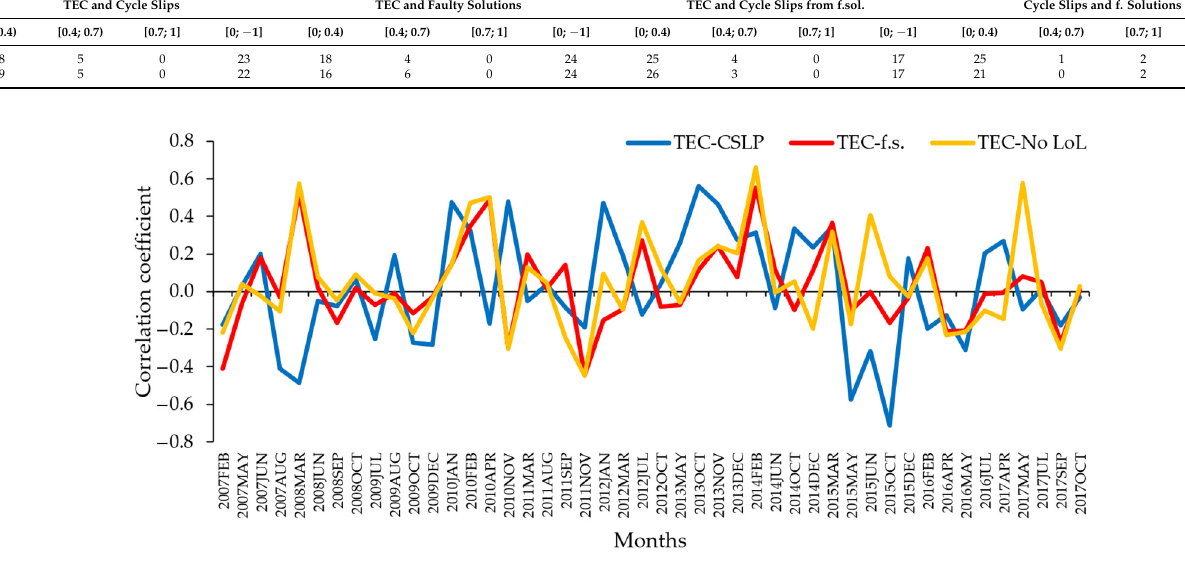
Figure 14. Graph of Pearson’s coefficient values in 3 cases.